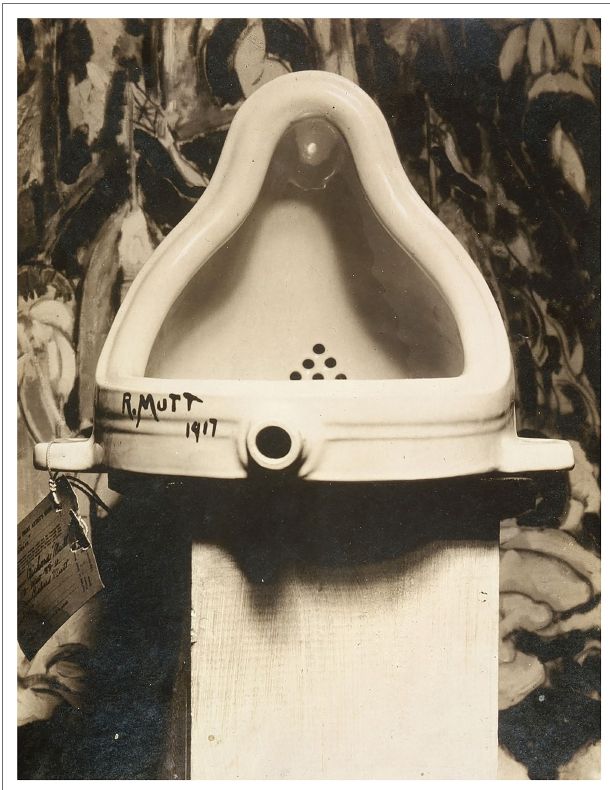
FIGURE 1 | Fountain by Marcel Duchamp as photographed by Stieglitz (2017). Reproduced with